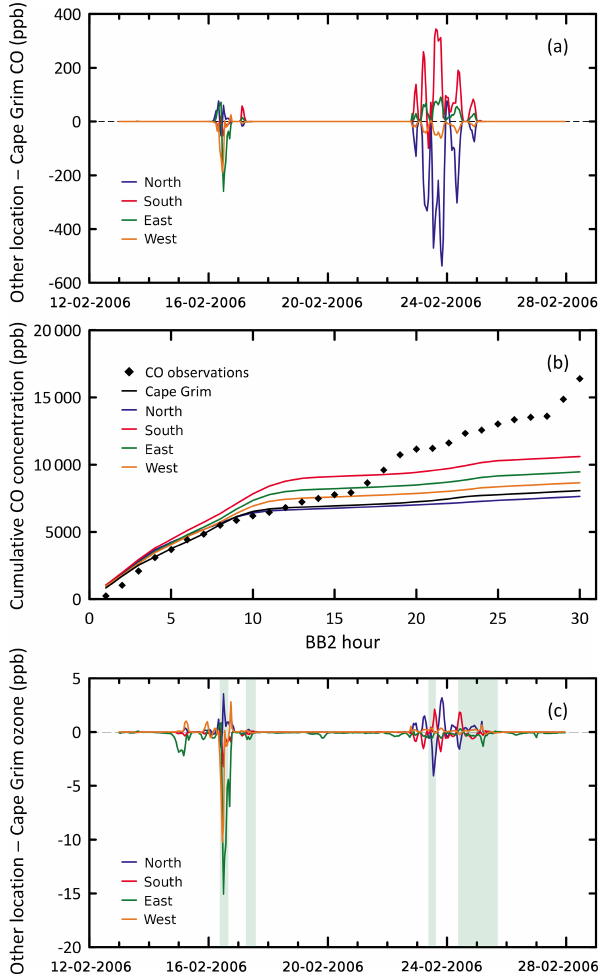
Figure 10. Simulated spatial variability using TAPM–CTM with MCE = 0.89 showing (a) time series of CO over 2 weeks of fire (BB1 and BB2 shown), (b) the observed and modelled cumulative concentration of CO over the 29h duration of BB2 and (c) time se- ries of O 3 over the 2 weeks of fire. The four modelled O 3 peaks at the Cape Grim grid point are shaded. Panels (a, c) show the dif- ference between simulated concentrations at Cape Grim and at four surrounding grid points 1km north, south, east and west of Cape Grim. Panel (b) shows simulated cumulative CO at Cape Grim and at four surrounding grid points. Observations are black